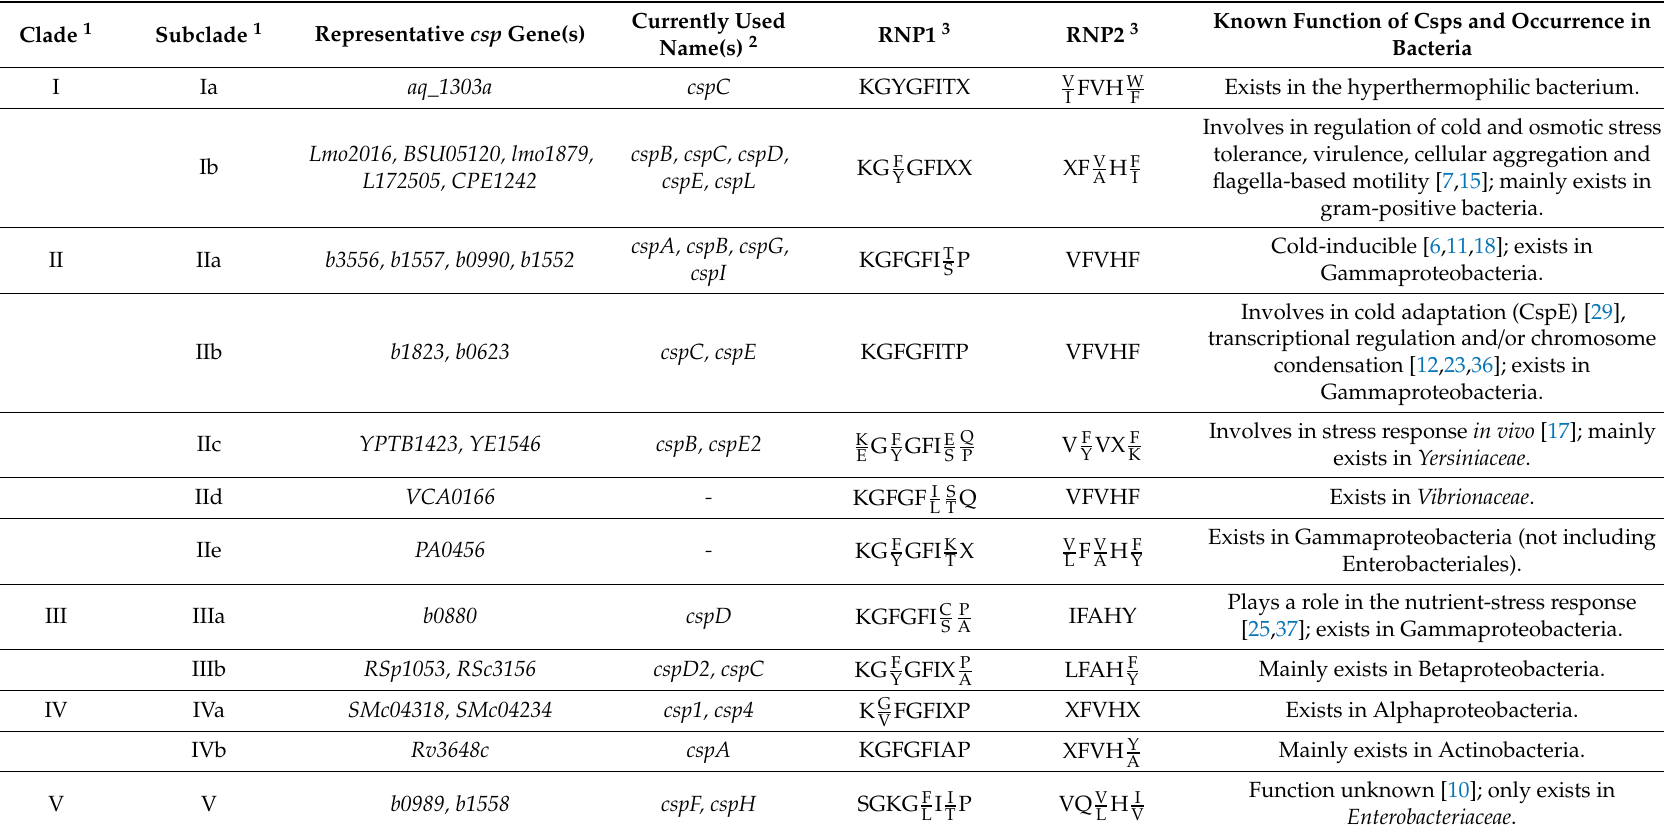
Table 1. Cold shock protein gene clades in